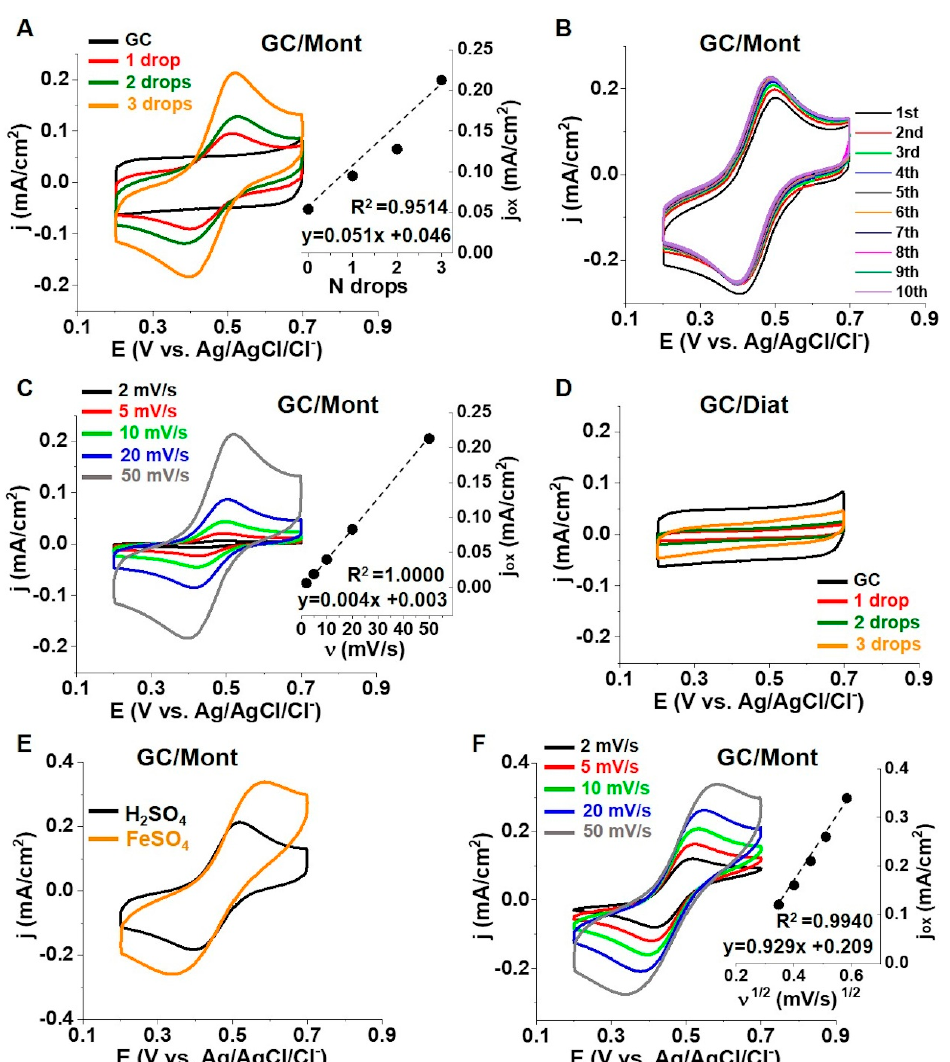
Figure 3. ( A,D ) Effect of drops (amount of clay) on the voltammogram (steady-state) of ( A ) Mont and ( D ) Diat in 0.5 M H 2 SO 4 , v = 50 mV/s; ( B ) successive voltammetric cycles of a 30 µg (3 drops) deposit of Mont in 0.5 M H 2 SO 4 , v = 50 mV/s; ( C,F ) effect of the scan rate on the voltammogram of a 30 µg (3 drops) deposit of Mont in the absence ( C ) or presence ( F ) of dissolved iron (0.01 M FeSO 4 ) in 0.5 M H 2 SO 4 ; and ( E ) stabilized cyclic voltammograms of a 30 µg deposit of Mont in the absence or presence of dissolved iron (0.01 M FeSO 4 ) in 0.5 M H 2 SO 4 , v = 50 mV/s.